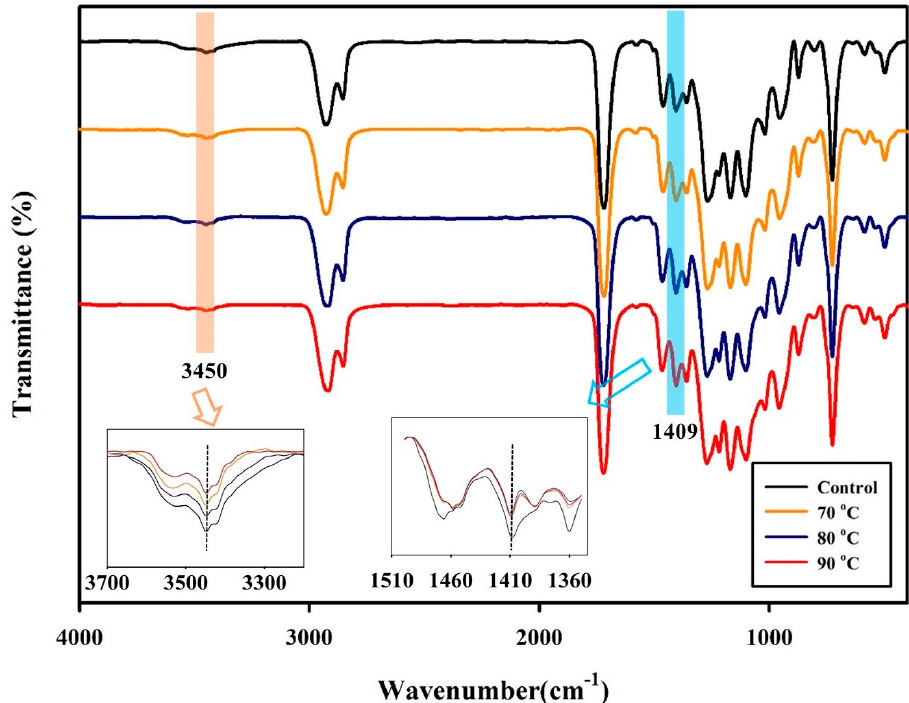
Figure 3. FT–IR spectra for PBSeT and PBSeT after SSP at 70, 80, and 90 °C for 40 min. (Insets: magnified 3450 and 1409 cm − 1 bands).